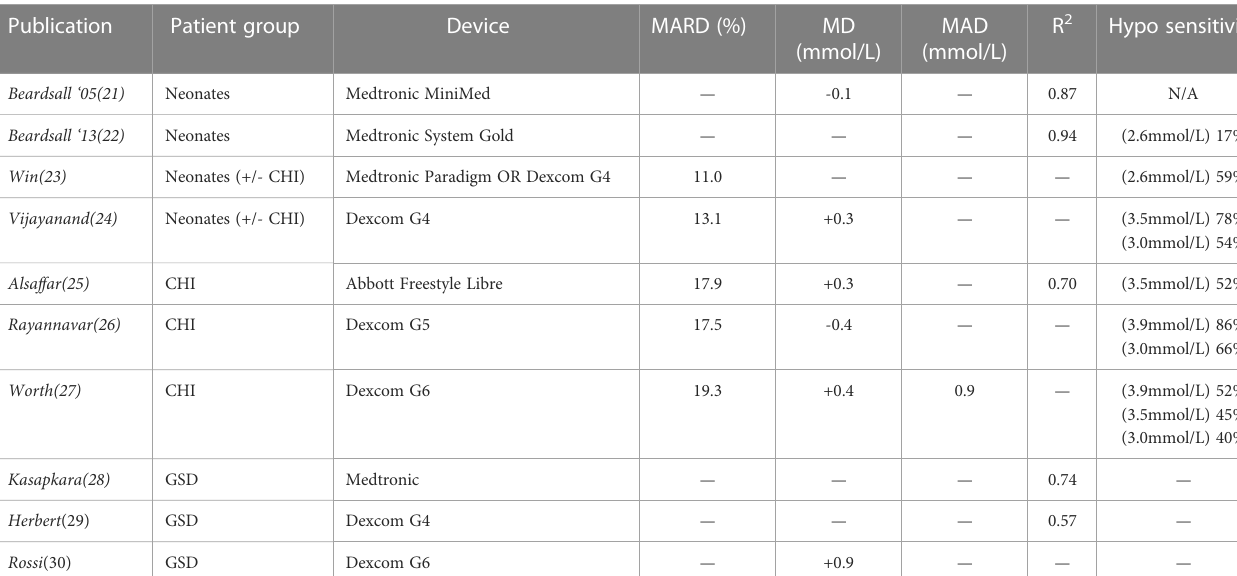
TABLE 1 Accuracy data for CGM use in non-diabetes childhood hypoglycaemia